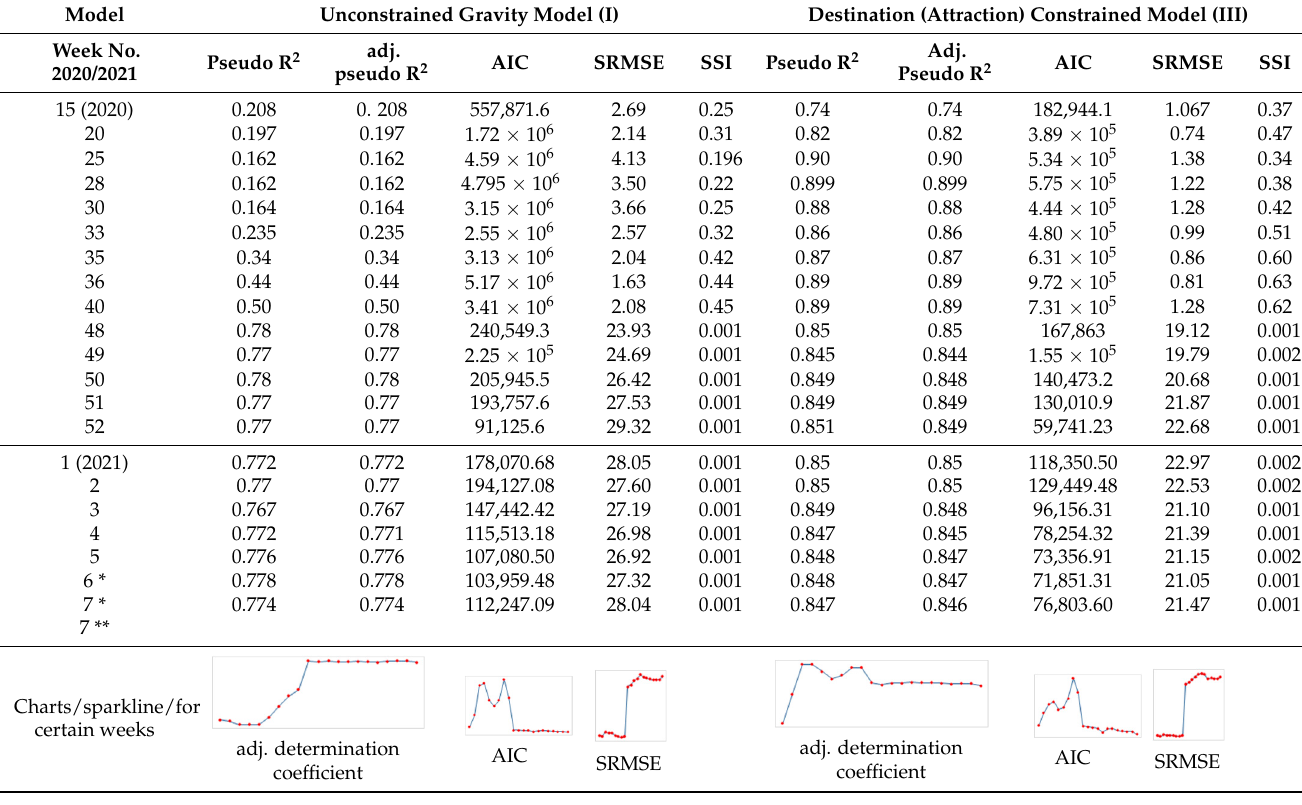
Table 2. Spatial interaction model fit statistics (* spatial verification; ** spatial